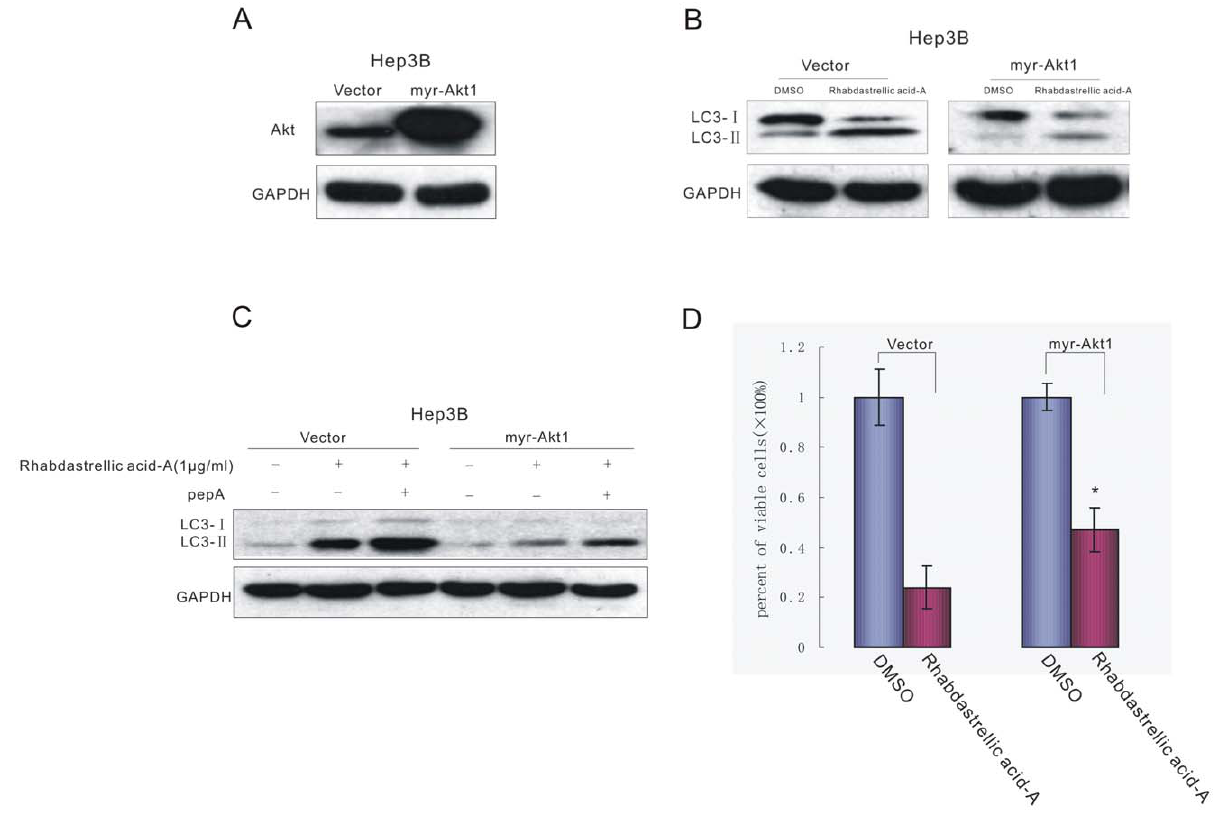
Figure 7. Constitutive active Akt expression could inhibit Rhabdastrellic acid-A-mediated autophagy. A. A. the positive clone stably expressed myr-Akt1 was analyzed by immunoblotting with Akt antibody. B. Hep3B cells were treated with 1 m g/mL Rhabdastrellic acid-A for 36 h in the absence or presence of constitutive active Akt ectopic expression. Then LC3 protein expression was analyzed. C. Cancer cells were treated with 1 m g/mL Rhabdastrellic acid-A and/or 10 m g/mL pepstatin A (pepA) for 36 h, Then LC3 protein expression was analyzed. D. After treatment, viable cells of two cell lines were measured. *, p , 0.05 vs. Rhabdastrellic acid-A (vector).